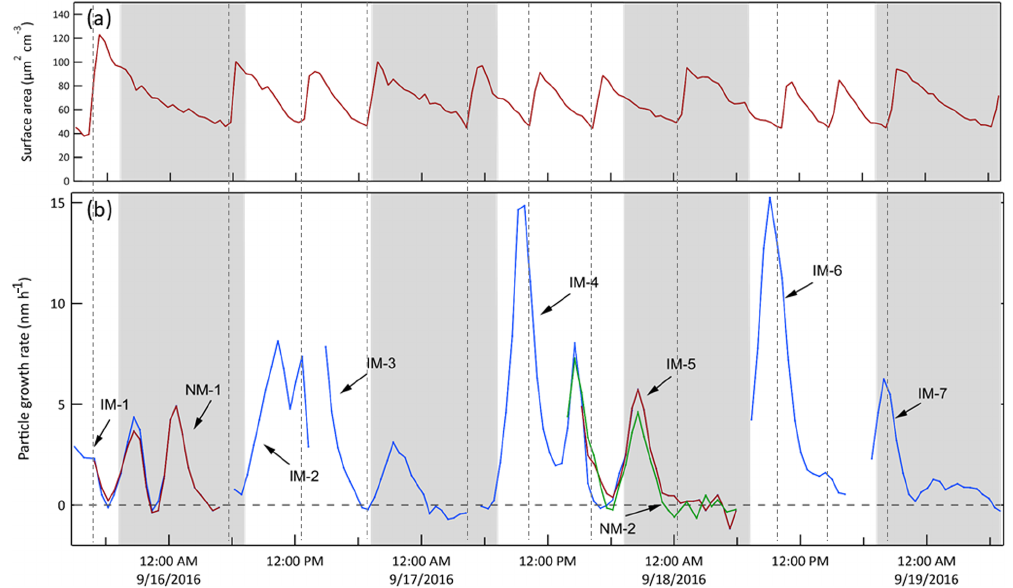
Figure 12. Particle growth rates calculated from the time series of lognormal fit diameters shown in Fig. 11. The different colors correspond to those used in Fig. 11. The integrated surface area concentration time series shown in Fig. 11 is included here to note the absence of any obvious reflection of that pattern in the growth rates. The shaded bands represent nighttime. Table 1. Comparison of chamber particle loss rates. Copied from Wang et al. (2014) with CAGE data added. Chamber Volume Wall Wall loss Particle Reference (m 3 ) material rate (h − 1 ) lifetime (h) CAGE 1 FEP This